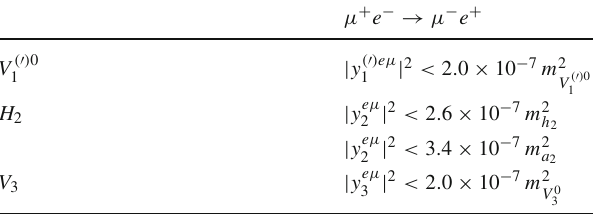
Table 3 Constraints from muonium-antimuonium conversion on the CLFV couplings in units of GeV − 2 . Here we assume all the CLFV couplings are real and symmetric. For H 2 , we provide the limits for the two cases of interest μ + e − → μ − e